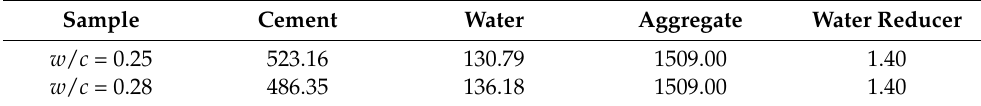
Table 1. The mixture proportions of the pervious concrete samples (kg/m 3